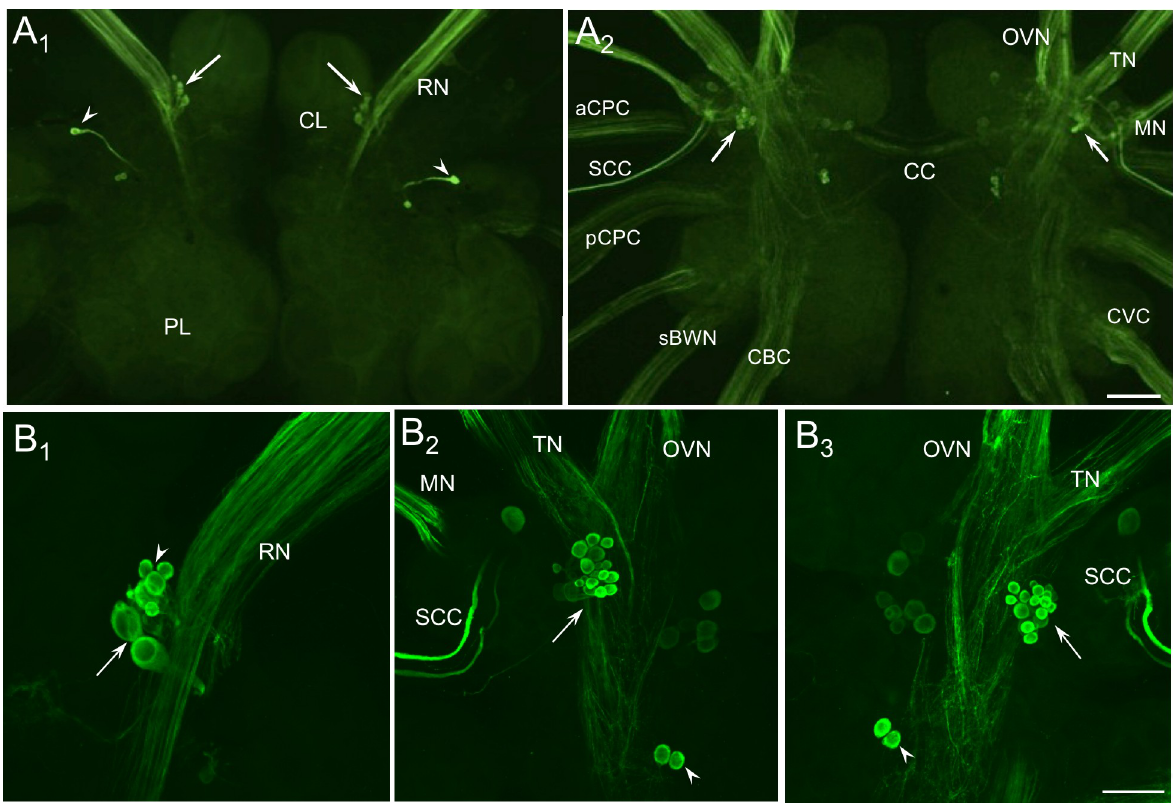
Fig 3. Tyrosine hydroxylase-like immunoreactivity (THli) in the cerebropleural ganglion. (A 1 ) Dorsal surface: THli fibers were abundant in the rhinophore nerve (RN). A cluster of 6–8 small cerebral neurons were stained proximal to the origin of each RN (arrows). An additional pair of cells was present lateral to each RN, one of which (arrowheads) projected a prominent fiber toward the midline. THli neurons were not observed in the pleural lobe. (A 2 ) Ventral surface: the majority of THli neurons in the cerebral ganglion were located near the confluence of the oral veil (OVN), tentacle (TN), and mouth nerves (MN). THli fibers were abundant in each of these nerves. One cluster of 15–20 small (10–20 μ m) neurons was located near the origin of each mouth nerve (arrows). Calibration bar = 400 μ m, applies to A 1 and A 2 . (B 1 ) Dorsolateral quadrant of the right cerebral ganglion. At higher magnification, the cluster of THli neurons situated at the origin of the RN was observed to be composed of heterogeneous cell bodies, with larger (30–50 μ m) somata located more posterior (arrow) and smaller (10–30 μ m) cells in a more anterior position (arrowhead). (B 2 , B 3 ) Ventrolateral quadrant of the right and left cerebral ganglia, respectively. The most intensely labeled cells were present in the cluster at the base of the MN (arrows) and exhibited less diversity in size, staining intensity, and segregation than the dorsal cluster cells. Bilateral homologs in this cluster were highly symmetrical with respect to number, location, and intensity. A pair of small (15–20 μ m) neurons was located posteromedial to the confluence of the TN and OVN (arrowheads), while a less brightly staining cluster of 3–5 somata lay anterior to those (asterisks). Calibration bar = 100 μ m, applies to b 1 -b 3 . Abbreviations: aCPC, anterior cerebropedal connective; BWN, body wall nerve; CL, cerebral lobe; CVC, cerebrovisceral connective; PL, pleural lobe; pCPC, posterior cerebropedal connective; sBWN, small body wall nerve; SCC, subcerebral